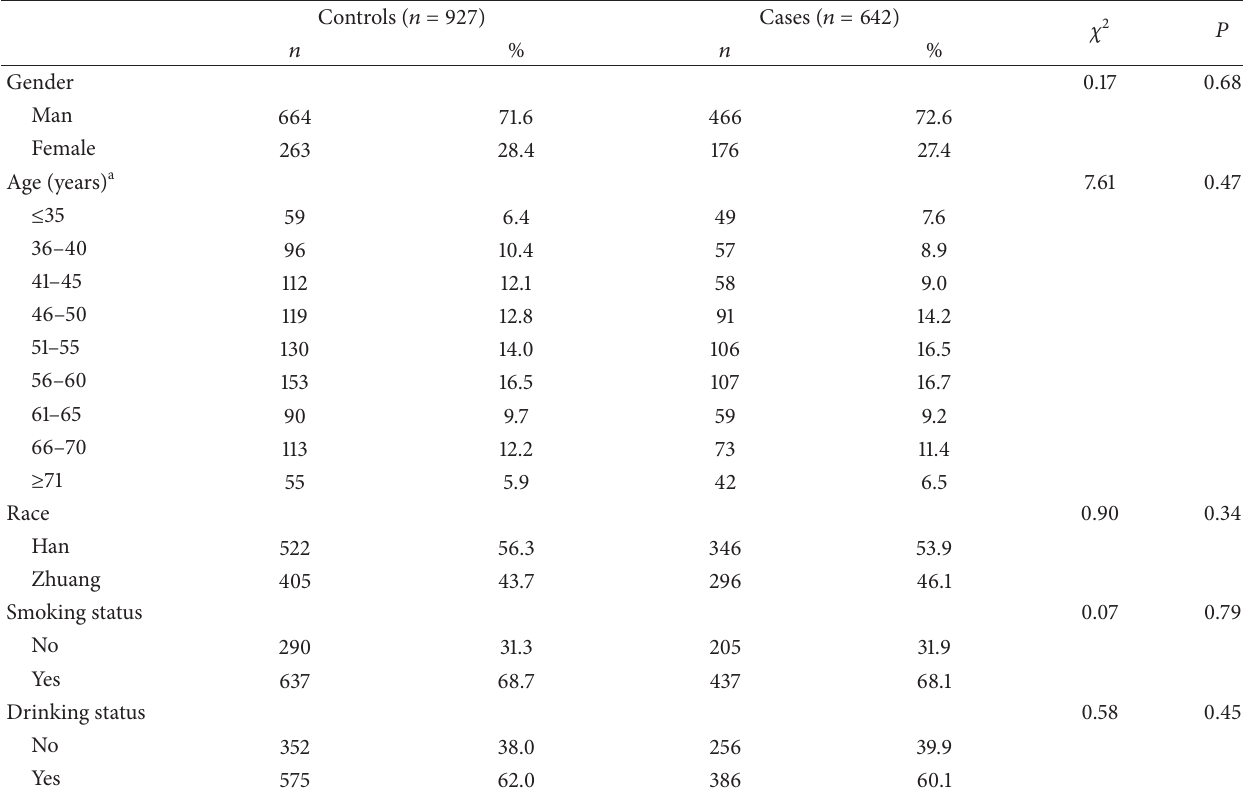
Table 1: Demographic details of GAA cases and controls.